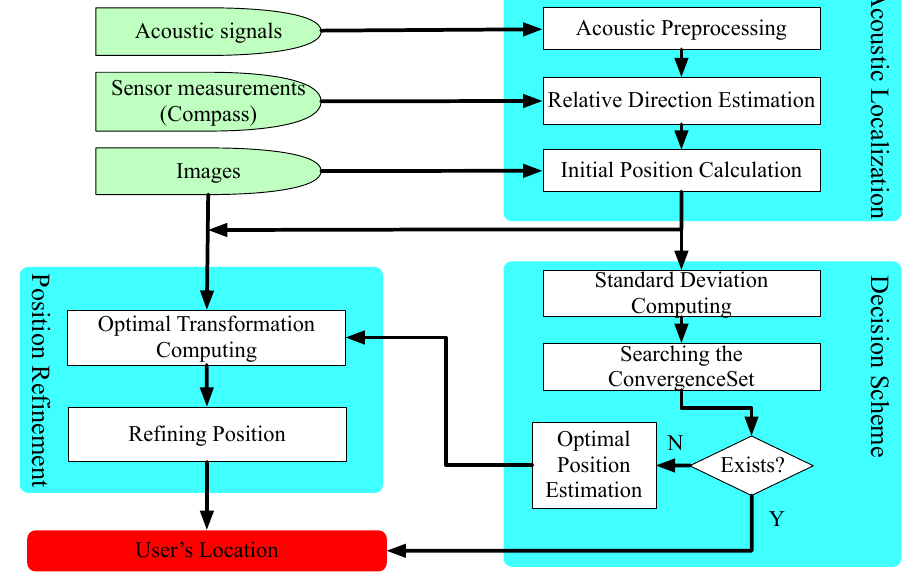
Figure 5. The architecture of SITE consists of three modules: Acoustic Localization , Decision Scheme , and Position Refinement